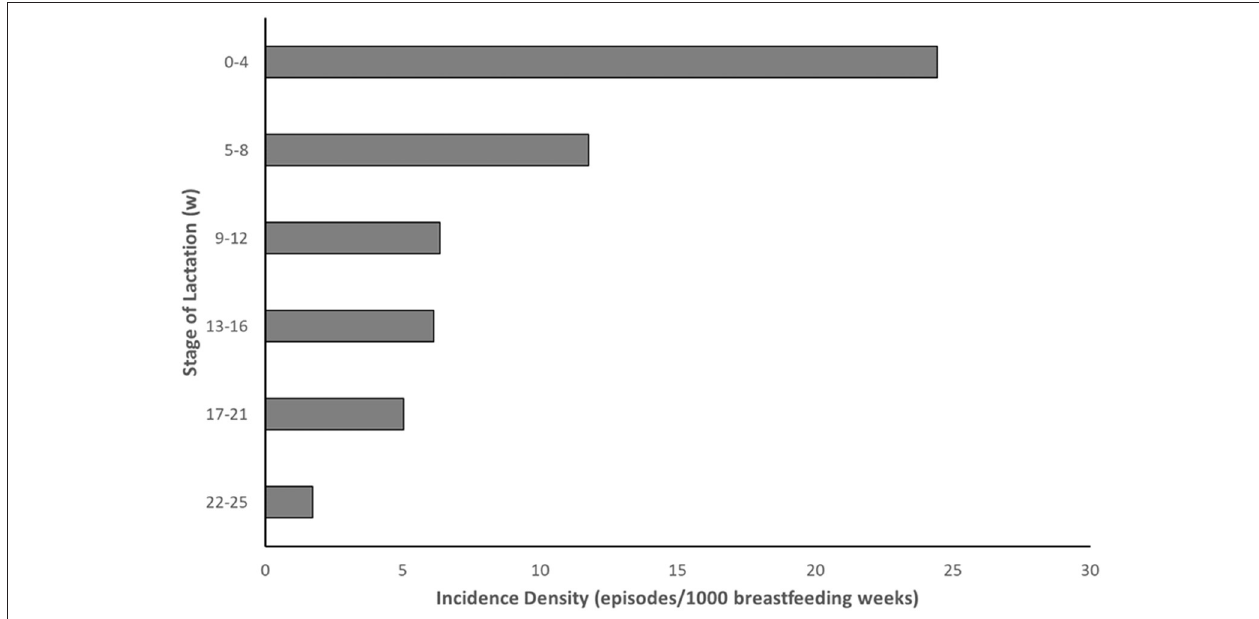
FIGURE 1 | Incidence of mastitis over the course of lactation [Data adapted from Wilson et al. (3)].